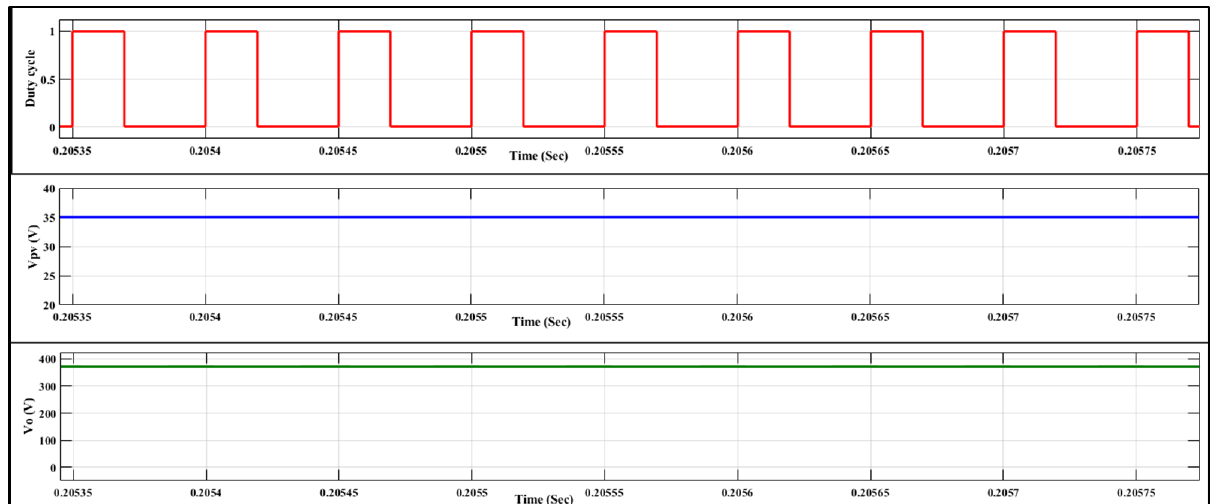
Figure 12. Simulated waveform for solar PV module output voltage (V pv ) and output voltage (V o ) of